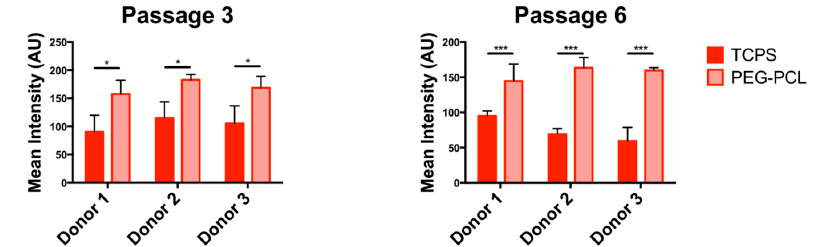
Figure 4. Osteogenic differentiation of hMSCs. Human mesenchymal stem cells (hMSCs) were stained with Alizarin Red after one month of osteogenic differentiation. Increased Alizarin Red staining was observed on PEG-PCL at both passage 3 and passage 6 compared to TCPS. The staining morphology was drastically different at for TCPS at passage 6 relative to TCPS at passage 3 with little staining for donor 2, while donors 1 and 3 had patches of positive staining, indicating a decrease in differentiation potential over serially passaging of the cells. Mean intensity of the stain is plotted for all donors for each substrate with n = 3 independent experimental replicates, in which PEG-PCL had increased relative stain intensity compared to TCPS for all donors at both passages. * p < 0.05, *** p < 0.001. Scale bar = 100 μ m. Int. J. Mol. Sci. 2018 , 19 , x FOR PEER REVIEW